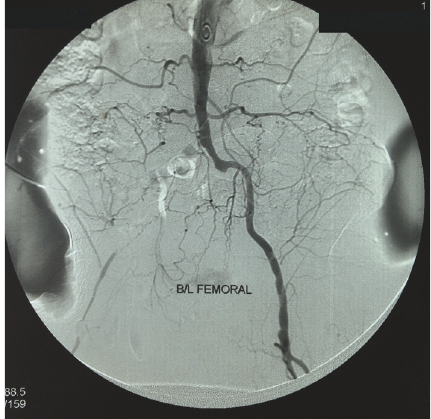
Figure 3: Digital subtraction angiography showing severe long segment stenosis of right-side iliofemoral